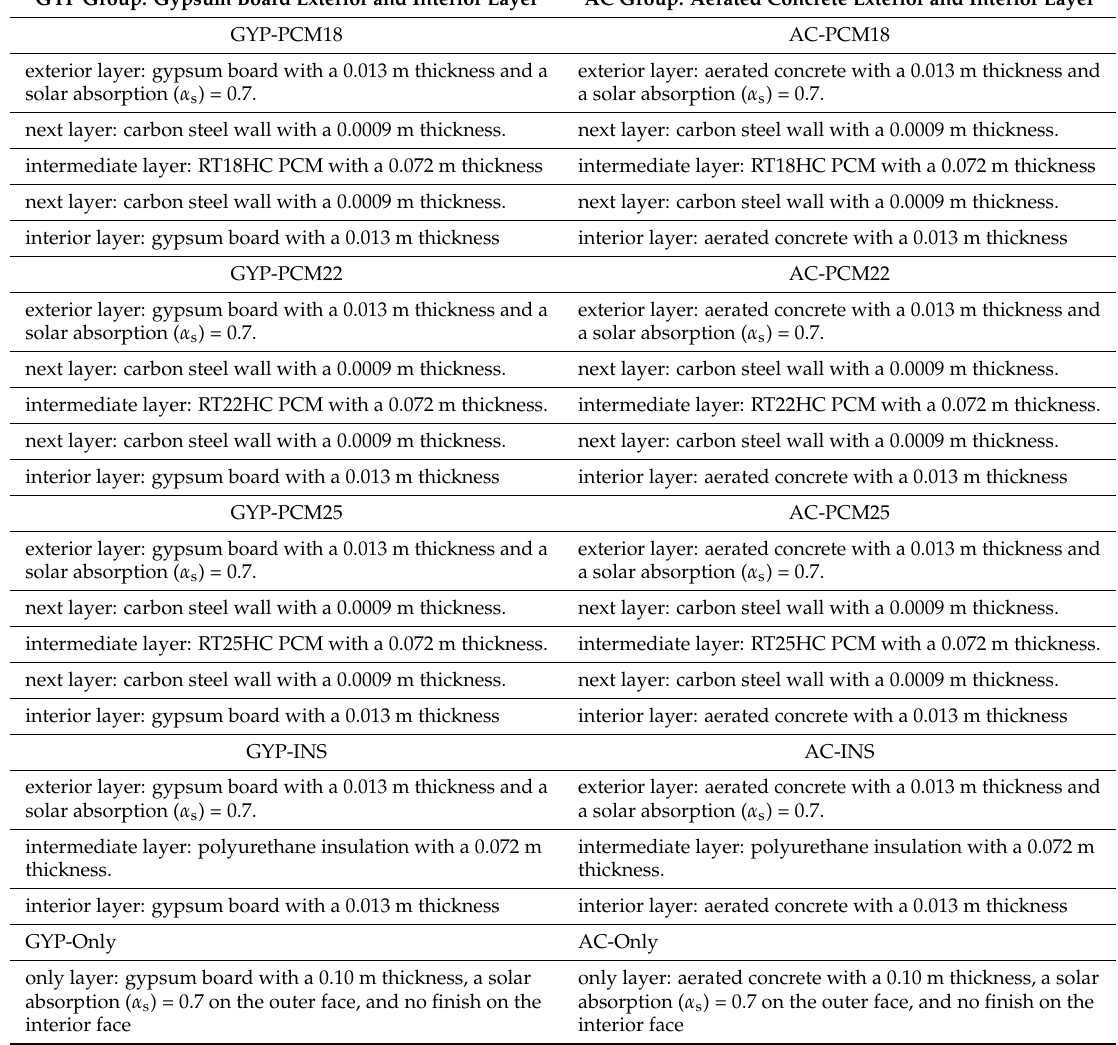
Table 5. Study case scenarios with their construction system layer configuration.“PCMXX” indicates the using of the studied PCM’s as intermediate layer in the studied constructive systems, “INS” indicates the using of polyurethane insulation as intermediate layer in the studied constructive systems, “Only” indicates using of a construction system applied to the walls and ceiling composed of three layers of the same material, which can also be considered as one homogeneous